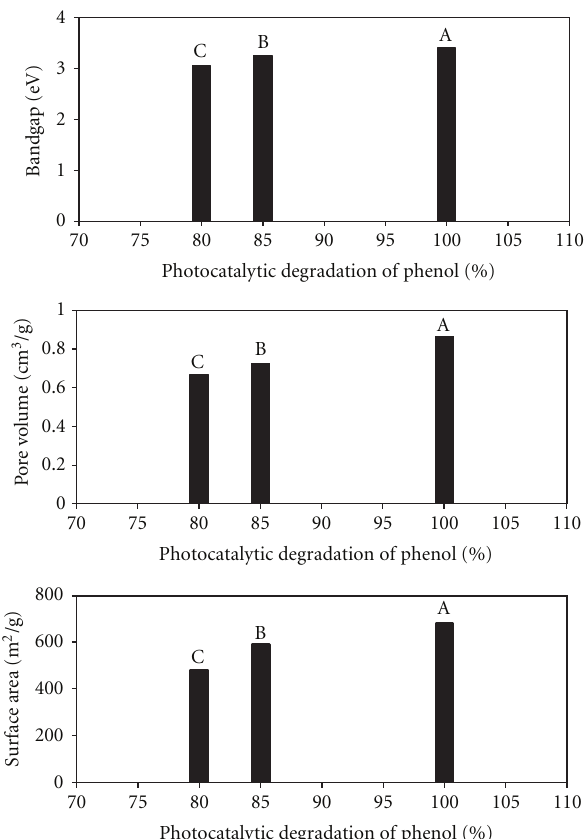
Figure 9: E ff ect of physical parameters of the materials on their photocatalytic